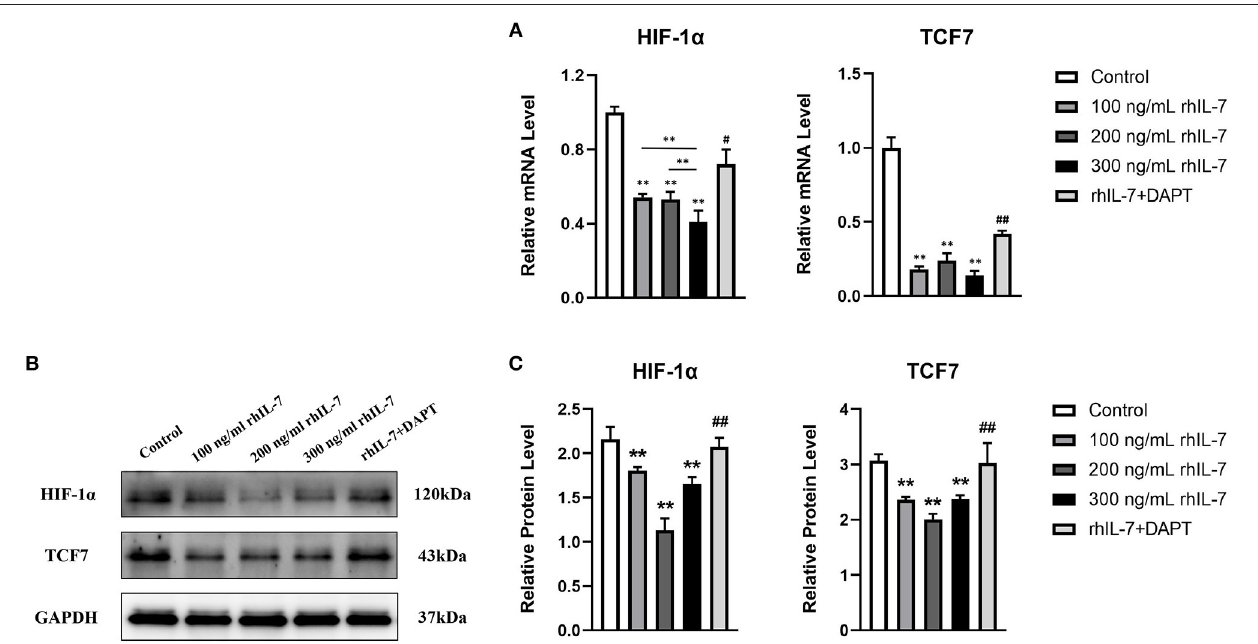
FIGURE 5 | Effect of rhIL-7 on signal molecules related to the immune response in hPDLCs. (A–C) The mRNA and protein levels of HIF-1 α and TCF7 in hPDLCs were detected by RT-qPCR and WB after treatment with different concentrations of IL-7 for 24h. A summary of the results is shown in the bar graphs. n = 3. ** p < 0.01.